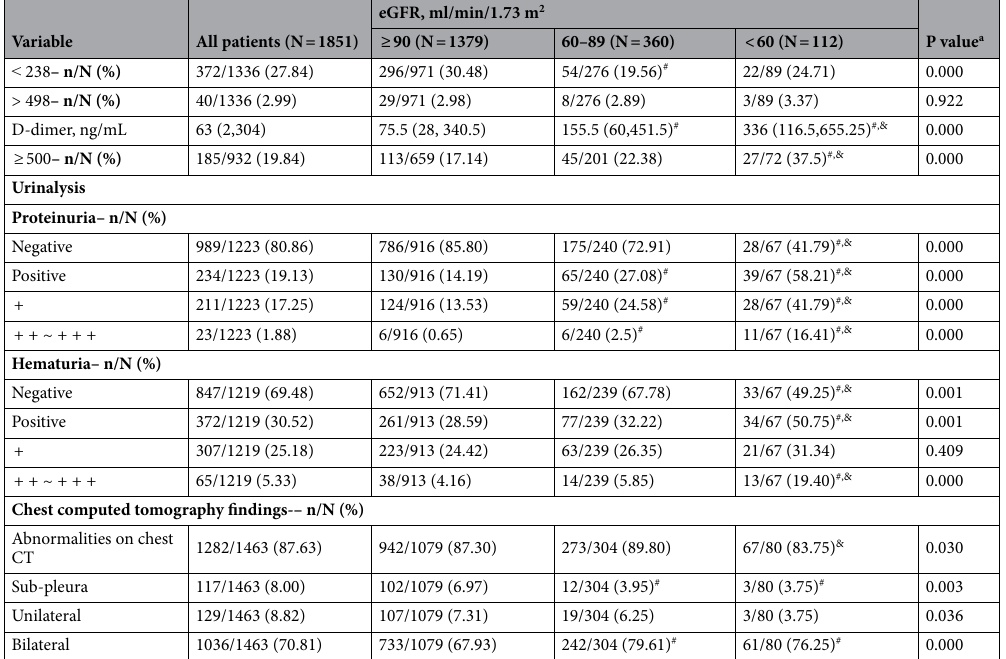
Table 2. Laboratory and radiological findings of COVID-19 patients stratified according to eGFR levels. Data are expressed as median (interquartile range) or no./total no. (%). a P values were calculated using the Kruskal– Wallis test or chi-square test. COVID-19, coronavirus disease 2019; eGFR, estimated glomerular filtration rate. # vs GFR ≥ 90 & vs 60 ≤ GFR <